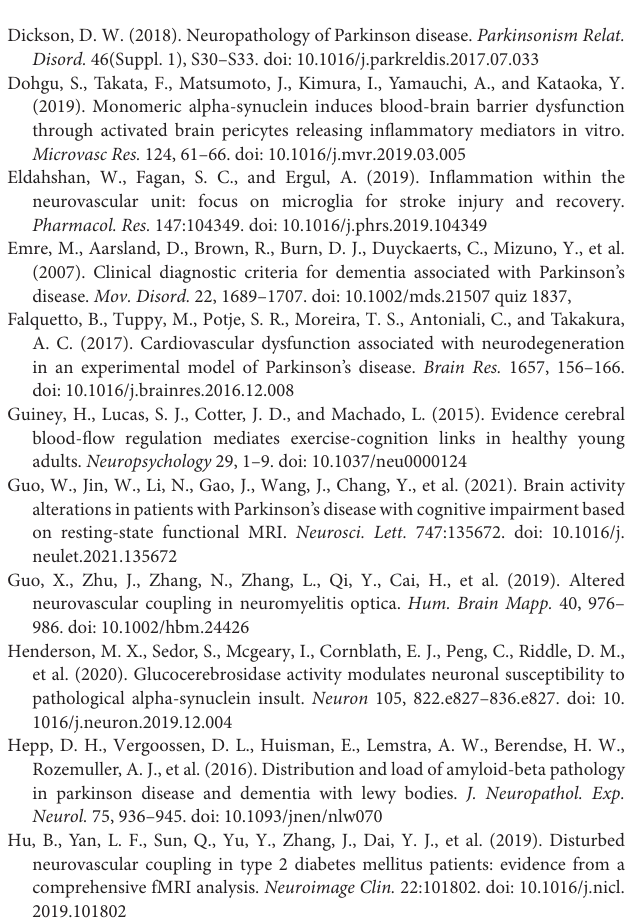
Supplementary Figure 2 | The brain regions with significant differences of CBF among groups. The voxel-based analysis demonstrates the survived clusters among HC, PD-NC, and PD-MCI groups (A) , between HC and PD-NC groups (B) , between HC and PD-MCI groups (C) , and between PD-NC and PD-MCI groups (D) . These clusters are referred to multiple comparisons correction using the FWE rate (a cluster-defining threshold of P = 0.001 and a corrected cluster significance of P < 0.05). The region with the significant difference among the three groups is shown with the warm color (for A ). The significantly increased ratio relative to HC in the group is shown with warm color, and the significantly decreased ratio relative to HC in the group is shown with cold color (for B,C ). The significantly increased ratio relative to PD-NC in the group is shown with warm color, and the significantly decreased ratio relative to PD-NC in the group is shown with cold color (for D ). CBF, cerebral blood flow; HC, healthy control; PD, Parkinson’s disease; NC, normal cognition; MCI, mild cognitive impairment; FWE, familywise error; R, right; L,